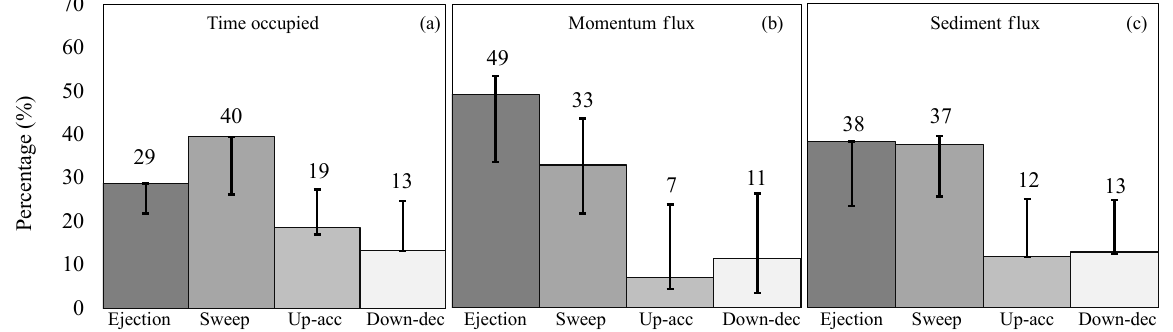
Figure 7. Quadrant analysis of coherent structures in above the measured mean critical velocity ranges ( u > u cr,measured ) showing the (a) time occupied, (b) momentum flux ( u (cid:48) ,w (cid:48) ), and (c) sediment flux (c (cid:48) w (cid:48) ). The error bars represent the maximum and minimum values of the total data.